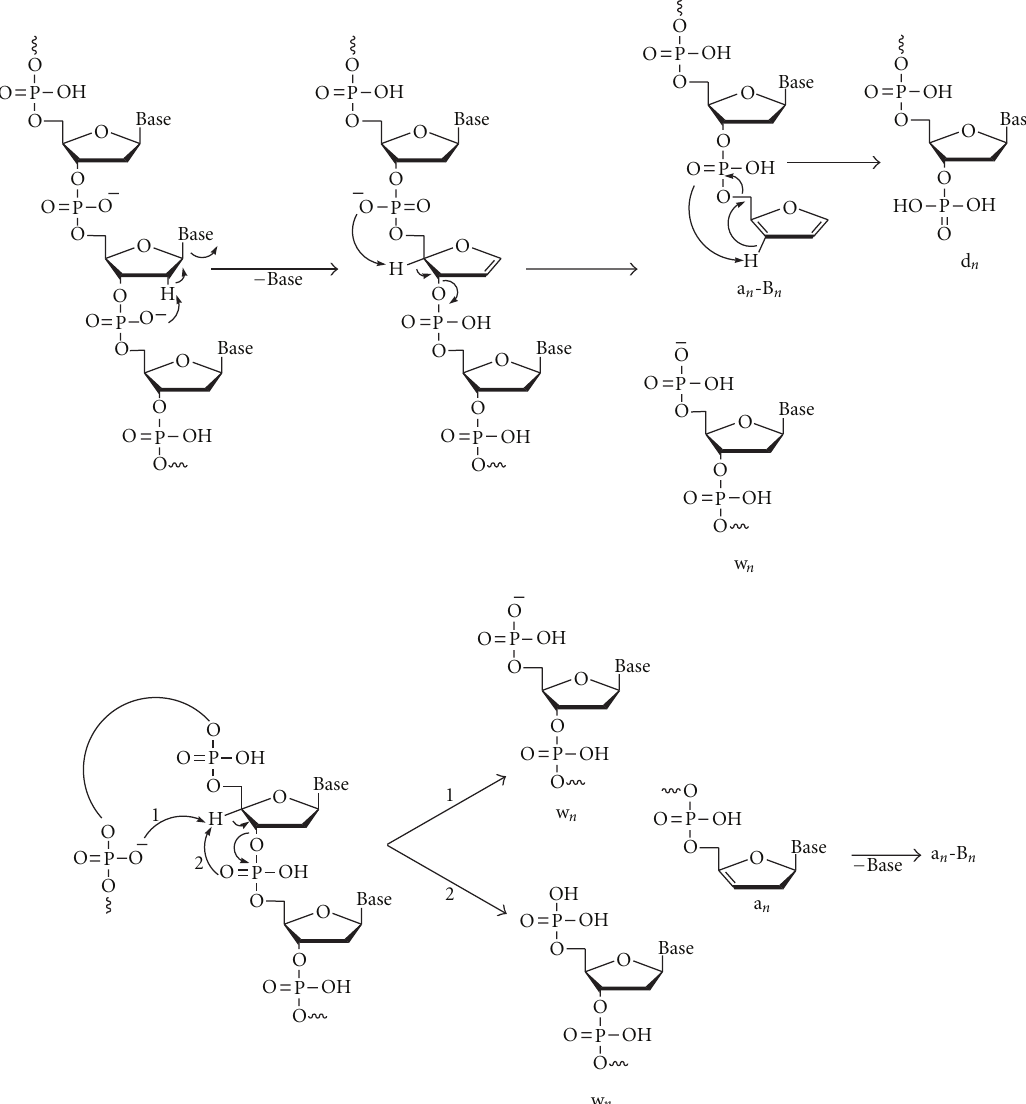
Scheme 5: The fragmentation mechanism of the oligonucleotide in two di ff erent ways. The mechanism in the upper panel shows the necessity of a charge proximate to the cleavage site. The mechanism in the lower panel does not require the charge proximate.